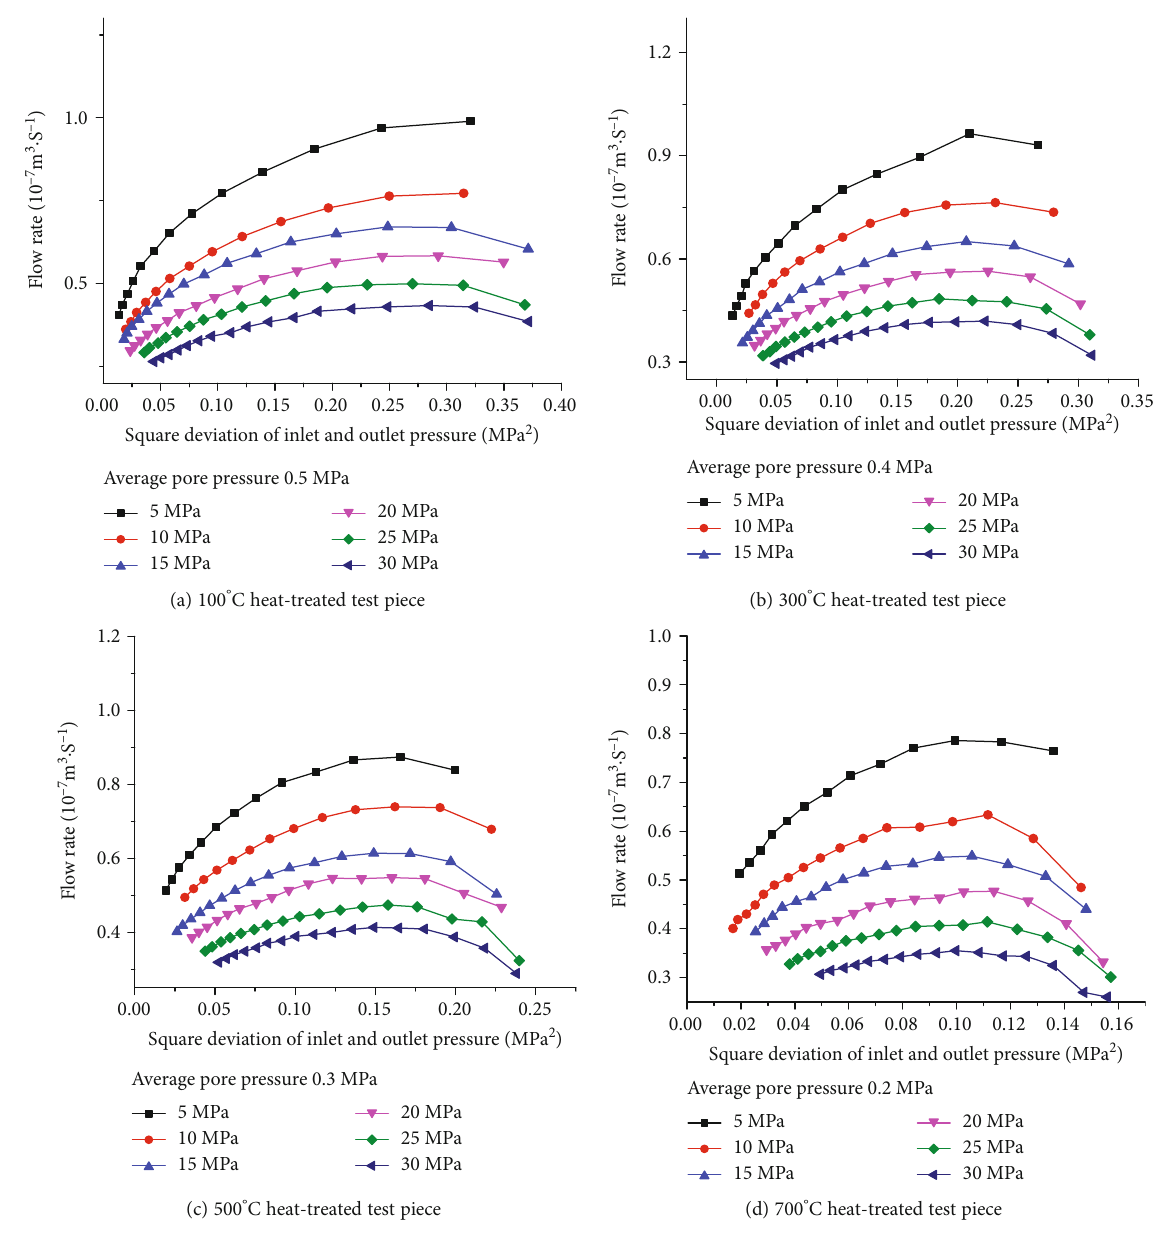
Figure 14: Relationships between the square deviations of the inlet and outlet pressure and fl ow